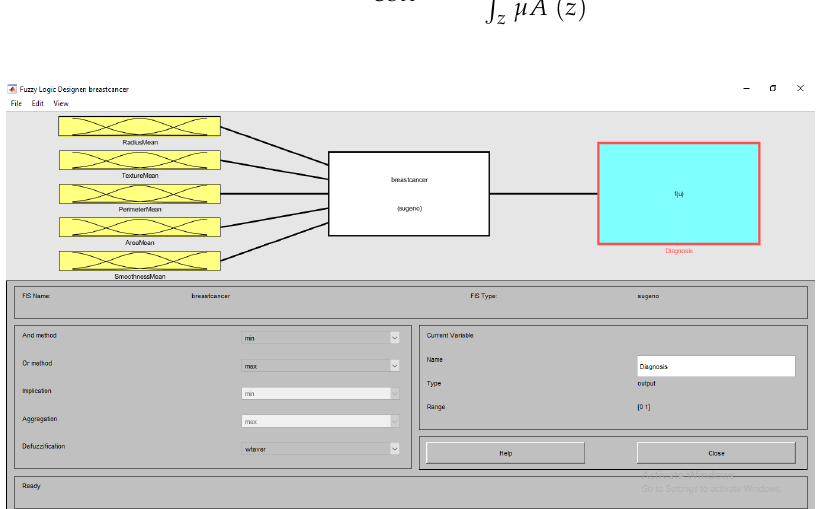
Figure 22. Defuzzification layer.